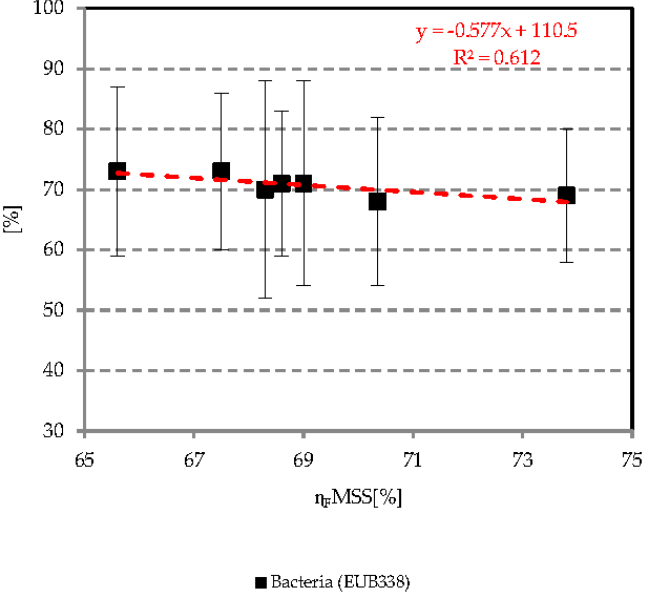
Figure 9. Relationship between the proportion of Bacteria (EUB338) and municipal sewage sludge fermentation rate ( η F MSS). Longer SMF exposure times significantly ( p = 0.05) decreased CH 4 yields in V4 and V5. The CH 4 content in the biogas was 61.5% ± 1.7% (V4) and 59.7% ± 2.2% (V5) (Figure 5), whereas Y VS in decreased to 396 ± 18 dm 3 CH4 /kgVS (V4) and 389 ± 18 dm 3 CH4 /kgVS (V5) CH 4 (Figure 6). Bacteria (EUB338) prevailed in the anaerobic bacteria consortium, accounting for over 70%. In contrast, a significant decrease was observed in the proportion of Ar- chaea (ARC915) and Methanosarcinaceae (MSMX860), i.e., to 23% ± 12% and 11% ± 6%, respectively (V5) (Table 3). The lowest CH 4 production levels through AD were noted in V6 and V7. The CH 4 content in the biogas fell within the narrow range of 54.8% ± 1.9% (V7) to 55.2% ± 1.2% (V6) (Figure 5). The Y VS in values were also similar, approximating CH 4 360 dm 3 CH4 /kgVS in both variants (Figure 6). The proportions of Archaea (ARC915) in the anaerobic microbial communities decreased to the lowest of the recorded values, i.e., 20% ± 11%, whereas that of Methanosaeta (MX825) fell to 6% ± 2% (V7) (Table 3). Variants V4 to V7 produced similar levels of η F MSS—from 65.6% ± 1.3% (V7) to 69.0% ± 3.1% (V5), and η VS—from 26.6% ± 1.5% (V7) to 32.3% ± 1.3% (V4). The observed efficiencies were significantly ( p = 0.05) lower than in variants V2 and V3. No signifi- cant variations in Y VS removed were noted in any of the variants. Its values ranged from b / CH 4 1764 ± 180 dm 3 /kgVS removed (V3) to 2138 ± 105 dm 3 /kgVS removed (V7) in the case of biogas and from 1131 ± 82 dm 3 /kgVS removed (V6) to 1194 ± 83 dm 3 /kgVS removed in the case of CH 4 (Figure 10).